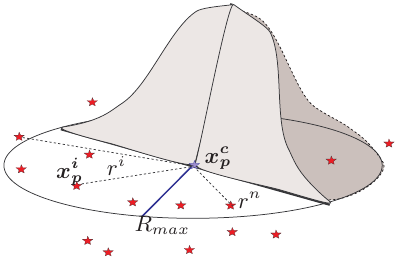
Fig. 5. Domain of